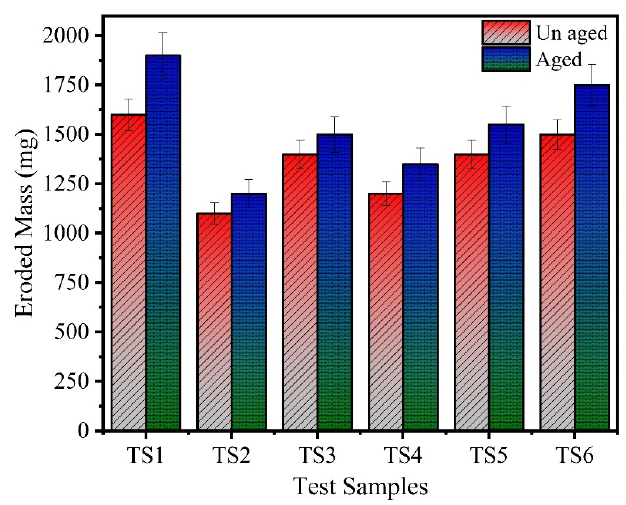
Figure 7. Eroded mass of the unaged and aged samples.